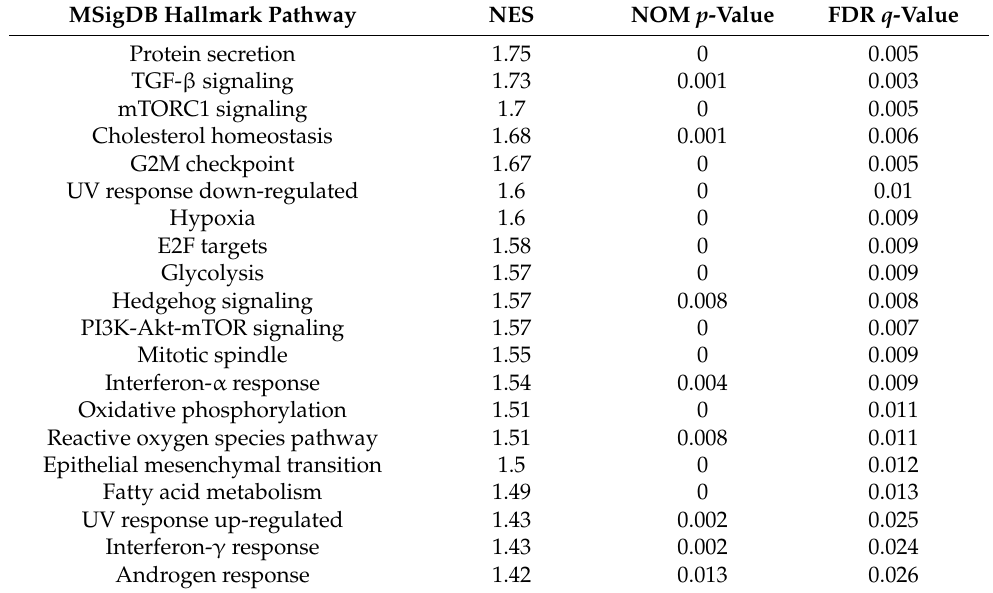
Figure 3. Functional gene expression profiling of colonic mucosa of DSS/AOM mice and control mice. The top ten biological pathways from the mouse 2019 WikiPathways database enriched from genes upregulated in DSS- and AOM-treated mice (blue square in Figure 2) ( A ) and genes upregulated in DSS/AOM-treated mice (red square in Figure 2) ( B ). DSS, dextran sodium sulfate; AOM, azoxymethane, DSS/AOM; dextran sodium sulfate + azoxymethane, GPCRs; G protein-coupled receptors, BMP; bone morphogenetic protein, WP; WikiPathways. Table 1. Gene Set Enrichment Analysis (GSEA) results according to the MSigDB Hallmark gene sets.